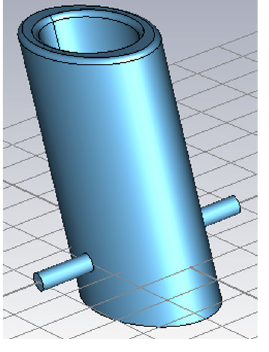
FIG. 44. The cavity geometry.